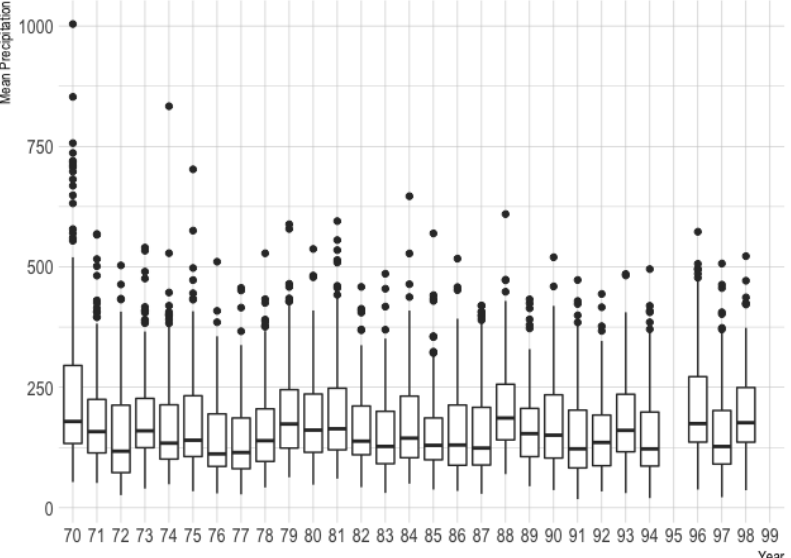
Figure 2. Boxplot for annual Precipitation (mm/month) means in the Central American Region